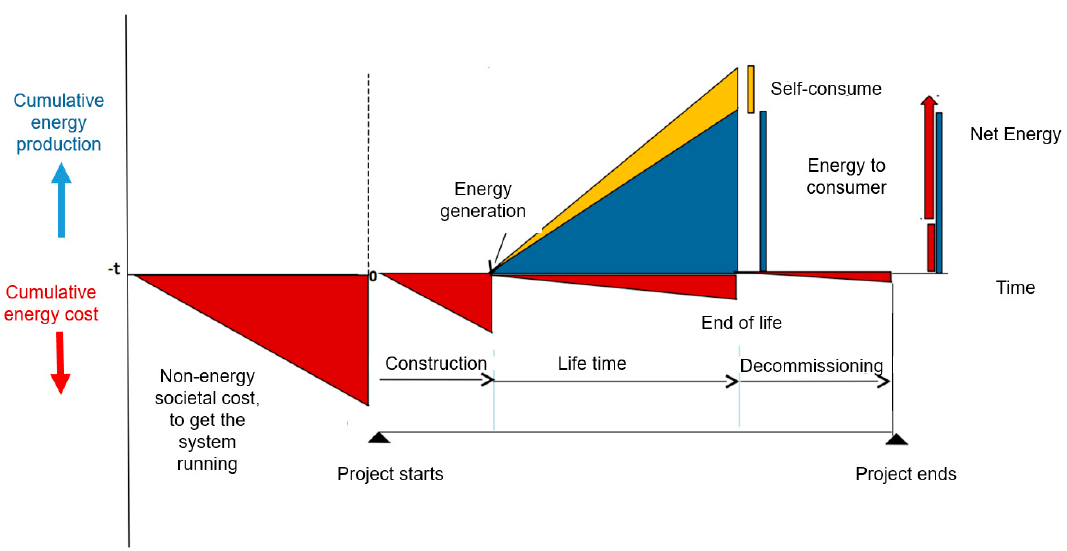
Figure 6. Net energy requirements for technology, adapted from Priesto and Hall [26].